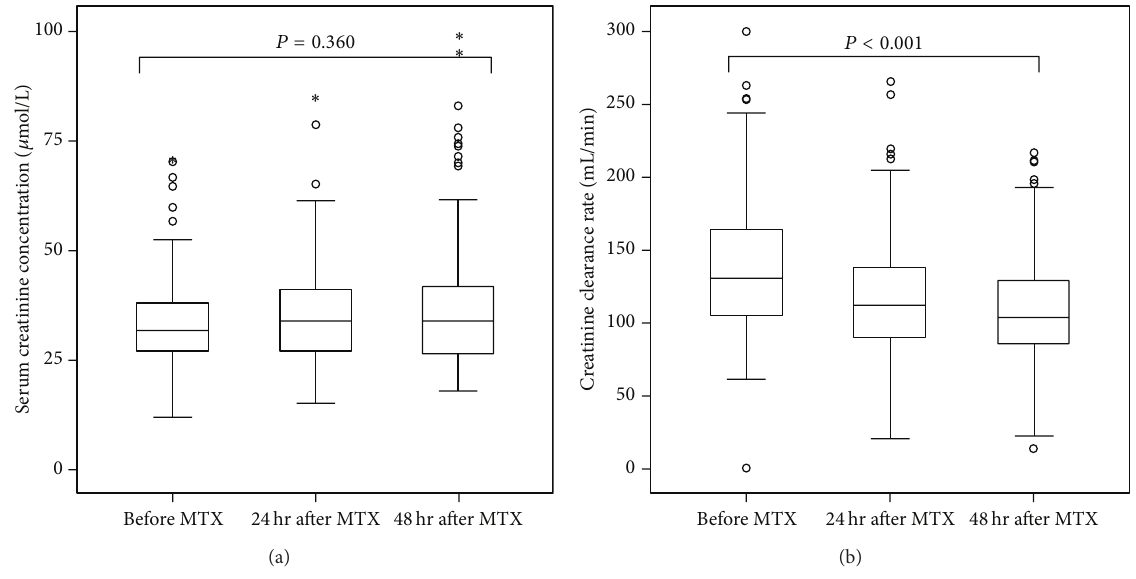
Figure 1: Serum creatinine (a) and creatinine clearance rate (CCR) change (b) after MTX infusion.